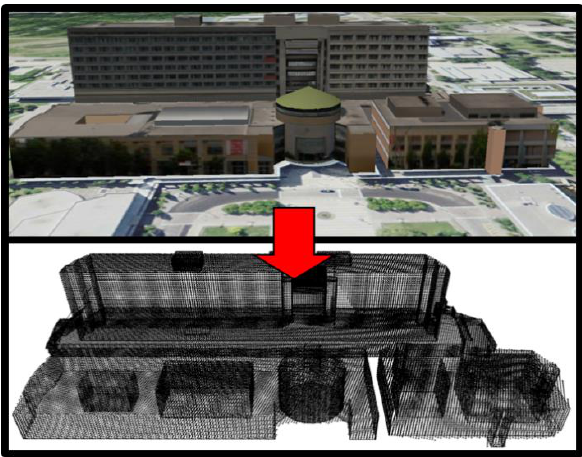
Figure 4: Converting 3D polygon building models to 3D point clouds: The Vari Hall